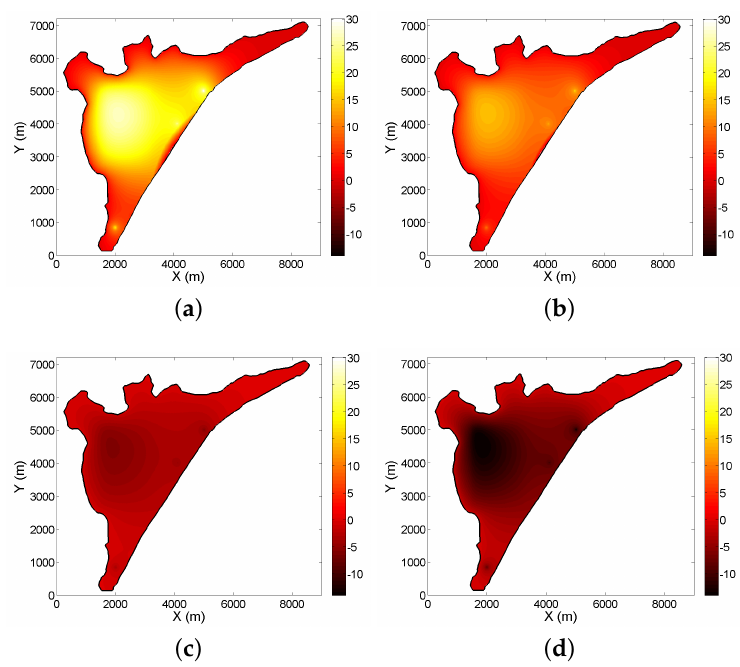
Figure 11. Difference between the position of freshwater/saltwater interface in four situations and the current condition “CUR”: ( a ) No-pumping “NOP”; ( b ) Recommendation of 120 L/capita/day “REC”; ( c ) After 10 years with 250 L/capita/day “10 Y”; ( d ) After 20 years with 250 L/capita/day “20